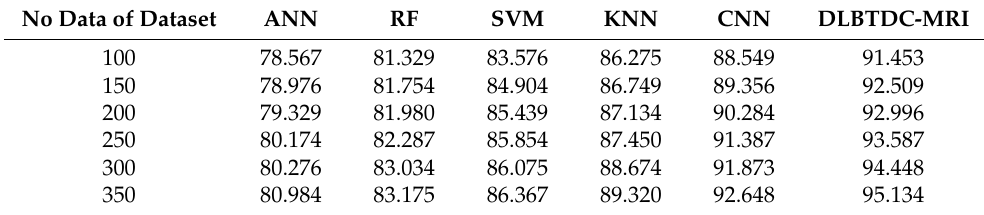
Figure 4. Precision of DLBTDC-MRI method with existing system. Table 1. Precision of DLBTDC-MRI method with existing